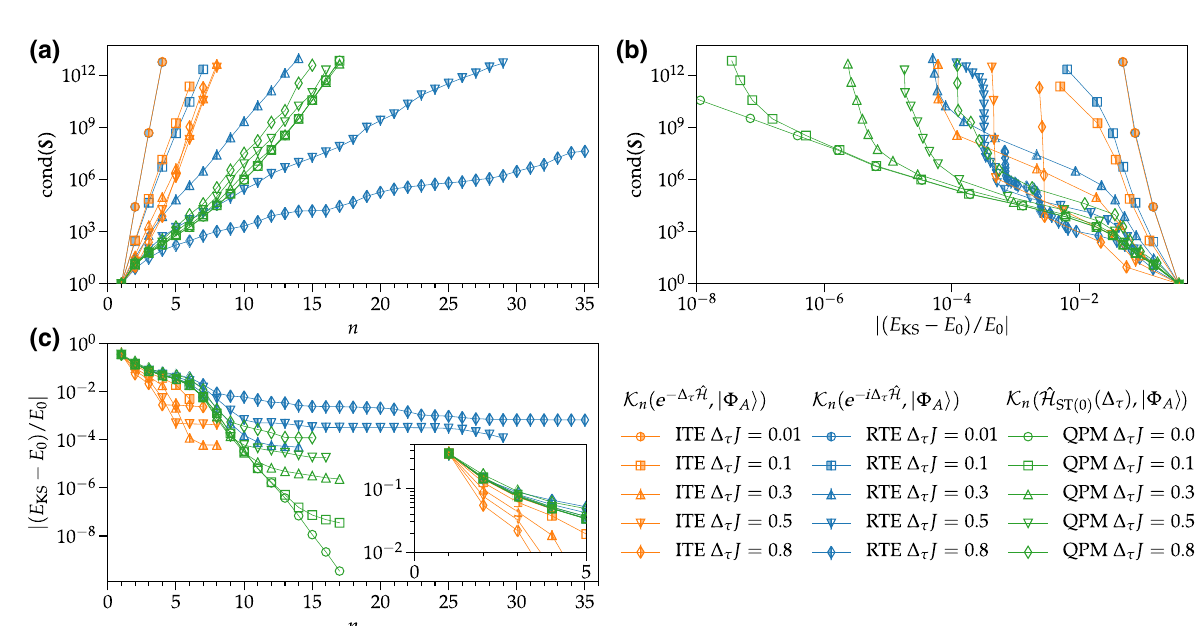
FIG. 8. (a) Condition number cond ( S ) as a function of the subspace dimension n , (b) condition number cond ( S ) as a function of the error in energy | ( E KS − E 0 )/ E 0 | , and (c) error in energy | ( E KS − E 0 )/ E 0 | as a function of the subspace dimension n for three different Krylov subspaces (ITE, RTE, and QPM) with several values of (cid:3) τ . Here, the Hamiltonian an N = 16 qubit ring with the exact ground-state energy E 0 and | ψ (cid:3) = | (cid:17) A (cid:3) is used as the reference state. For QPM, the Richardson extrapolation is not used ( r = 0). Notice that the results for ITE and RTE with (cid:3) τ J = 0.01 are identical in this scale. The inset in (c) is the enlarged plot for small n